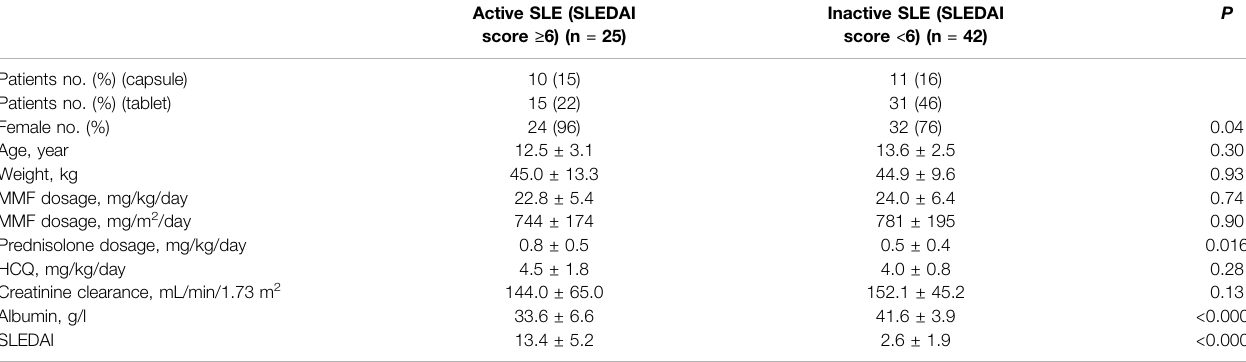
TABLE 1 | Characteristics of the patients with active and inactive SLE, as de fi ned using the SLEDAI score.